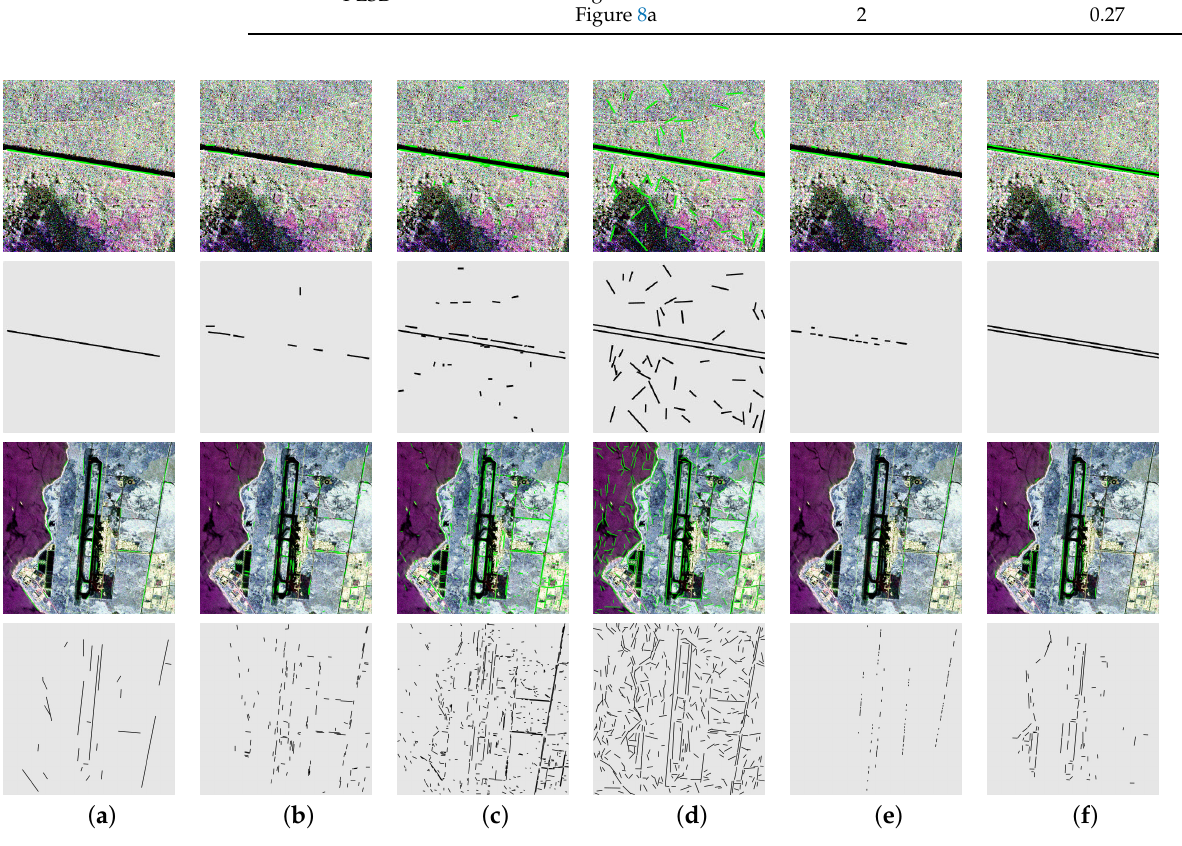
Figure 9. Line segment detection results of different methods for PolSAR image. ( a ) LSD. ( b ) EDLines. ( c ) Linelet-LSD. ( d ) LSDSAR. ( e ) HT. ( f )